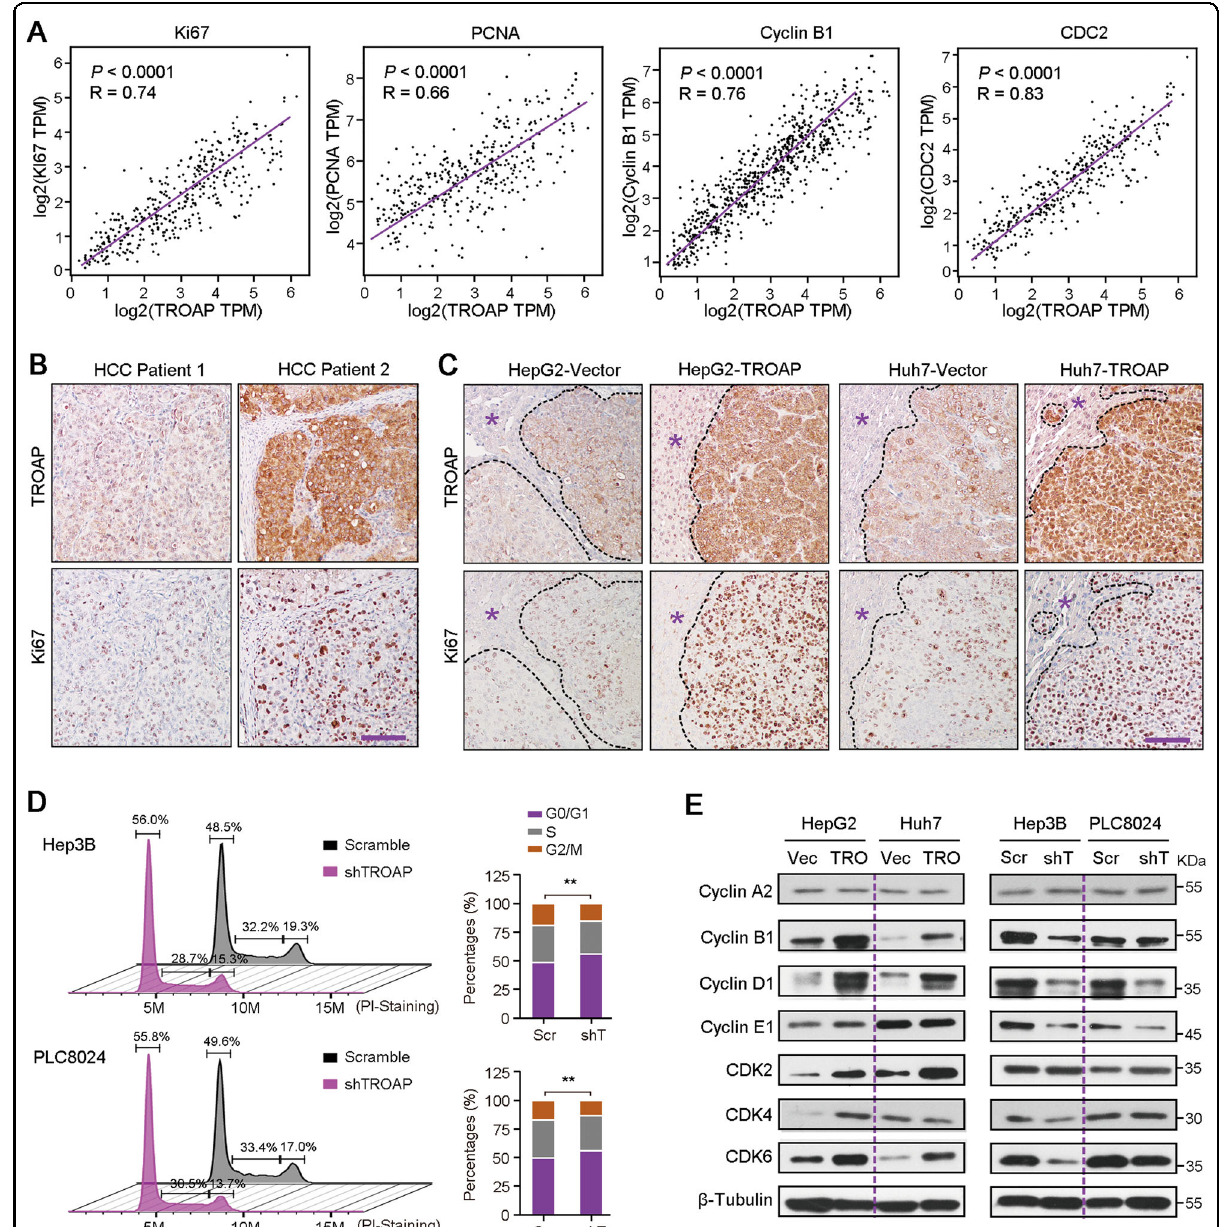
Fig. 1 TROAP enhances HCC cell growth by accelerating cell cycle process. A The mRNA expression correlations between TROAP and cell proliferation-associated genes in HCC tissues were analyzed using TCGA database. IHC staining with antibodies against TROAP and Ki67 were performed in serial sections from two HCC patients with low or high expression of TROAP ( B ), or from orthotopic xenograft tumors derived from vector or TROAP-transfected HepG2 and Huh7 cells ( C ), respectively. Scale bar, 200 μ m. In C , normal liver tissues were indicated by asterisks. D The cell cycle distributions of Hep3B and PLC8024 cells with or without TROAP silence were analyzed by fl ow cytometry. One way ANOVA; ** P < 0.01. E Western blotting was used to analyze the expressions of cell cycle-associated proteins in HepG2 and Huh7 cells transfected with vector or TROAP, and in Hep3B and PLC8024 cells with or without TROAP knockdown. β -Tubulin was also tested as a loading